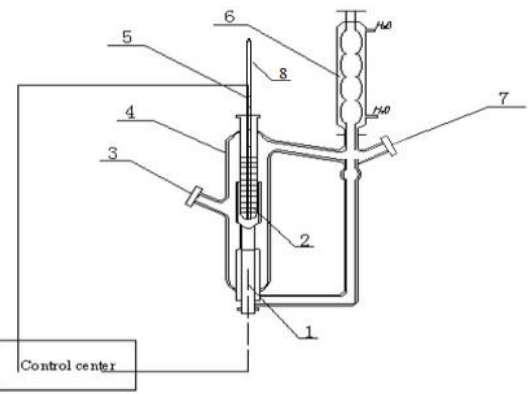
Figure 1. Constant pressure double circulation vapor–liquid equilibrium kettle. 1—heater rod; 2—thermometer sleeve tube; 3—liquid phase sample connection; 4—liquid phase sample connection; 5—thermal resistance; 6—condenser; 7—vapor phase sample connection; 8—mercury thermometer.